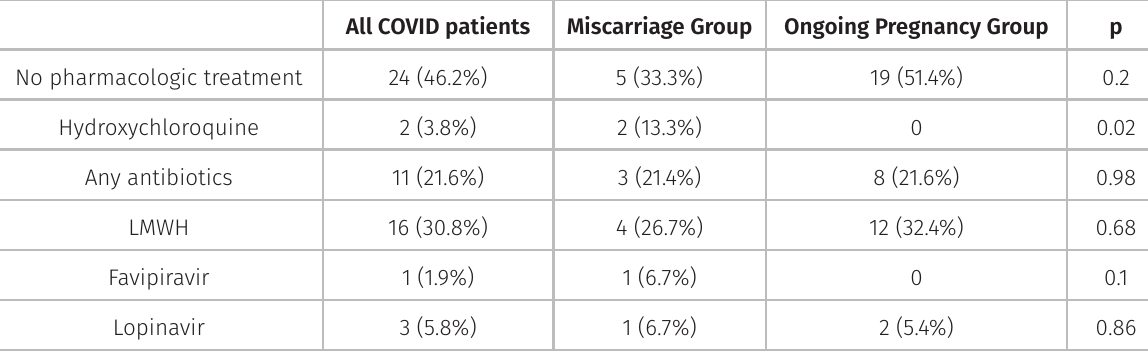
Table IV. Pharmacologic Treatments.